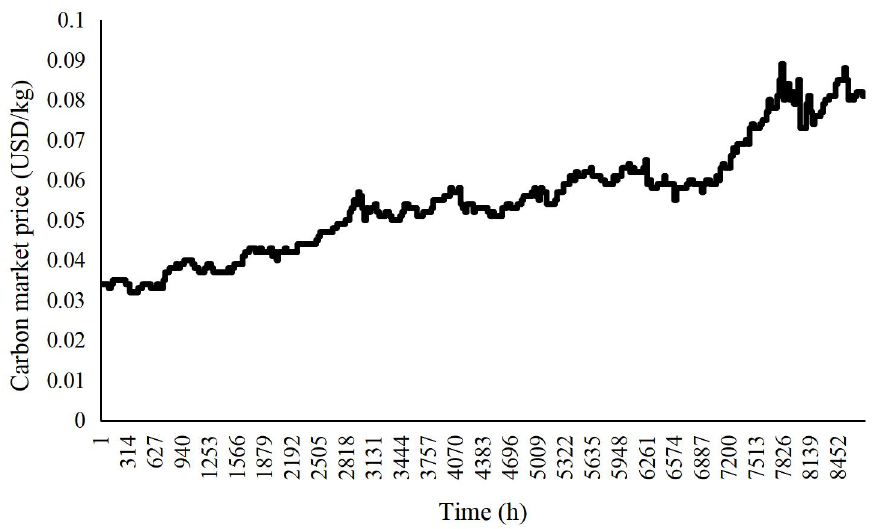
Figure 4. Carbon trading market price used in Case II [26].